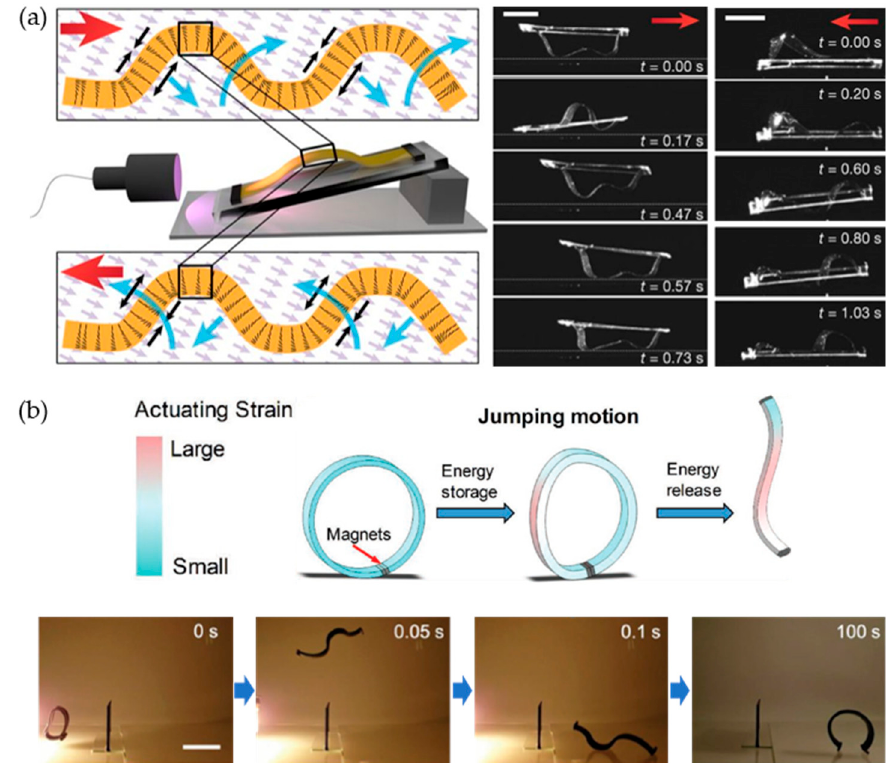
Figure 10. ( a ) Making waves in LCN films. ( b ) Jumping of CNT-LCE composites with magnets on both ends. ( a ) Reproduced with permission [17]. Copyright 2017, Nature Publishing Group. ( b ) Reproduced with permission [18]. Copyright 2019, Wiley-VCH.